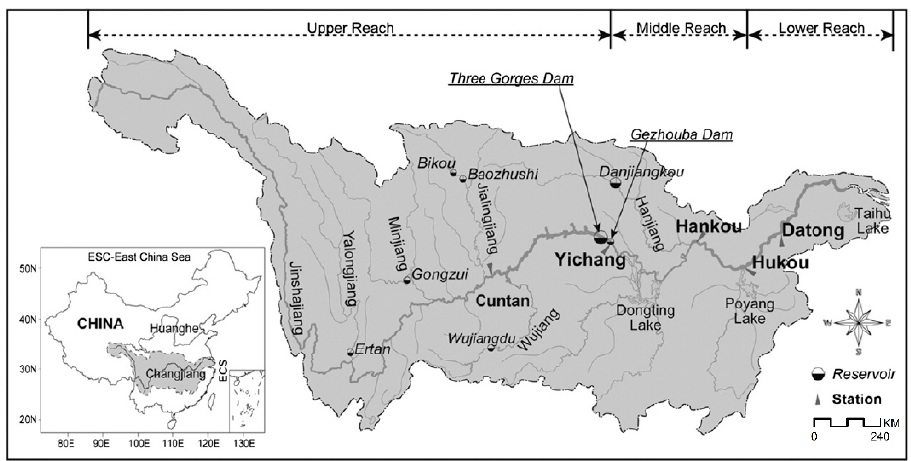
Figure 1. Sketch map of the Yangtze River basin.